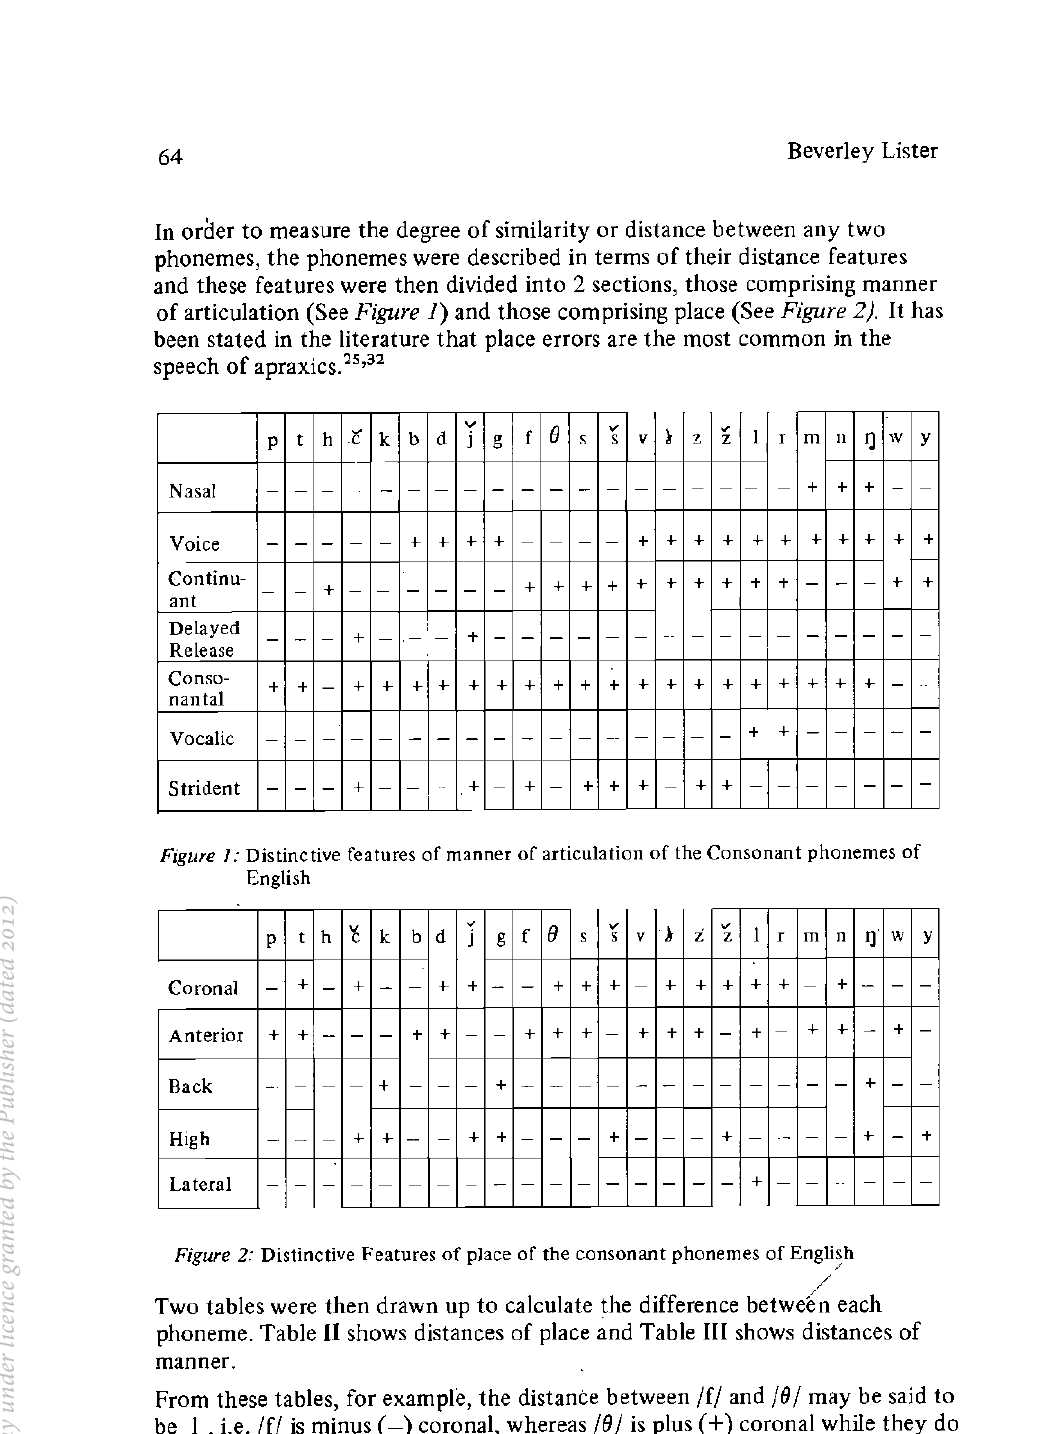
Figure 2: Distinctive Features of place of the consonant phonemes of English